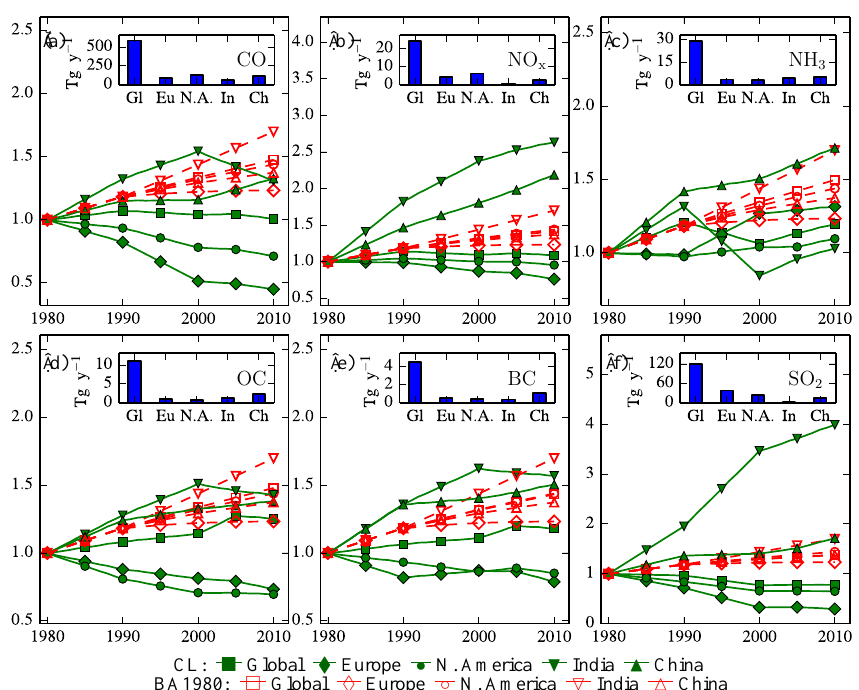
Figure 1. Normalized (to 1980 levels) annual mean anthropogenic emissions of CO, NO x , NH 3 , OC, BC, and SO 2 for the CL (green/solid) and BA1980 (red/dashed) simulations as a function of time. Different regions appear with different symbols: squares for the globe (Gl), diamonds for Europe (EU), triangles for China (Ch), inverted triangles for India (In), and circles for North America (N.A.). The histograms at the top of each panel show the absolute emissions in 1980 (used to normalize the emissions) for these regions that are used as reference to normalize emissions (also shown in Table